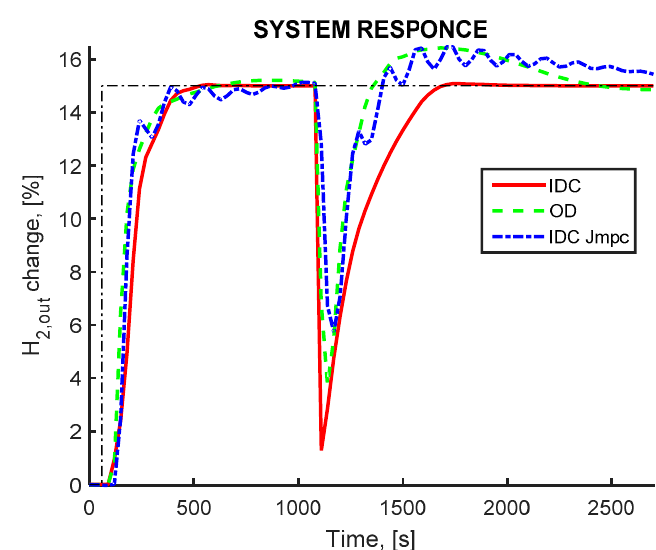
Figure 6. Pure hydrogen production rate (controlled variable). IMR flowsheet equipped with a membrane reactor, IDC( J COST ) framework (red continuous curve) OD framework (green dashed curve) IDC( J MPC ) framework (blue dashed-dot curve). Setpoint change for hydrogen production at 150 s and disturbance influence at 1000 s.